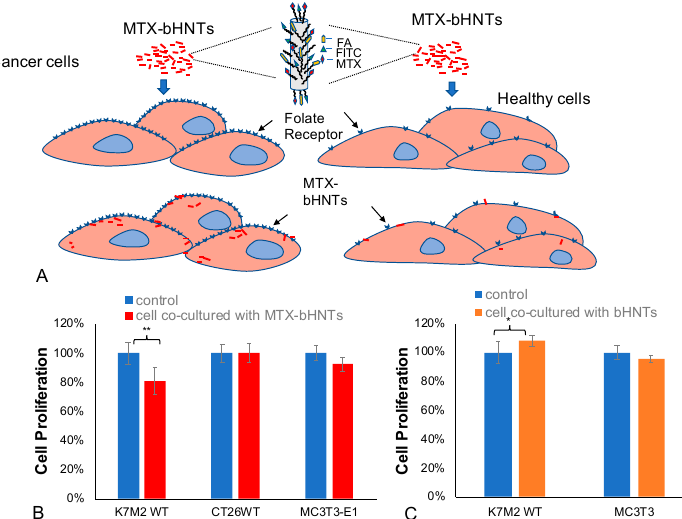
Figure 8. ( A ) Graphic depiction of osteosarcoma cells (K7M2WT), murine colon carcinoma cells (CT26WT) and preosteoblast cells (MC3T3) co-cultured with bi-HNTs. ( B ) Cell proliferation data after all three cell types were co-cultured with 50 µ g / mL drug loaded bi-HNTs for 24 h. ( C ) Cell proliferation of above 3 types of cells after co-cultured with 50 µ g / mL bi-HNTs for 24 h. (* represents p < 0.05, ** represents p < 0.005)